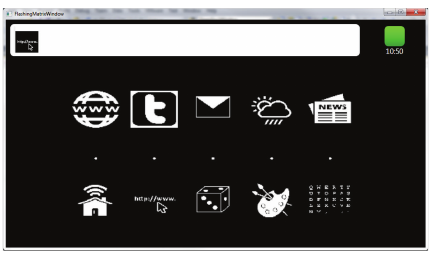
Figure 11: PUI of the web access